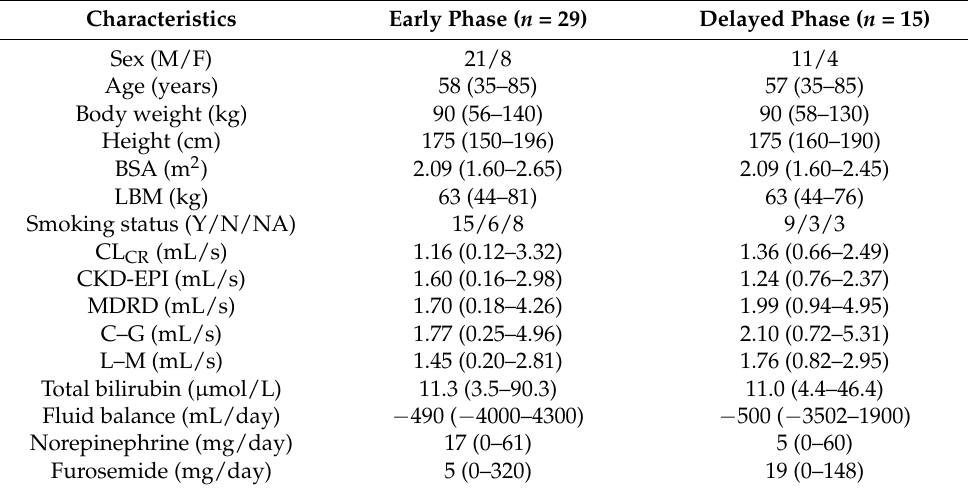
Table 1. Demographic, laboratory, and clinical characteristics of patients ( n = 30).